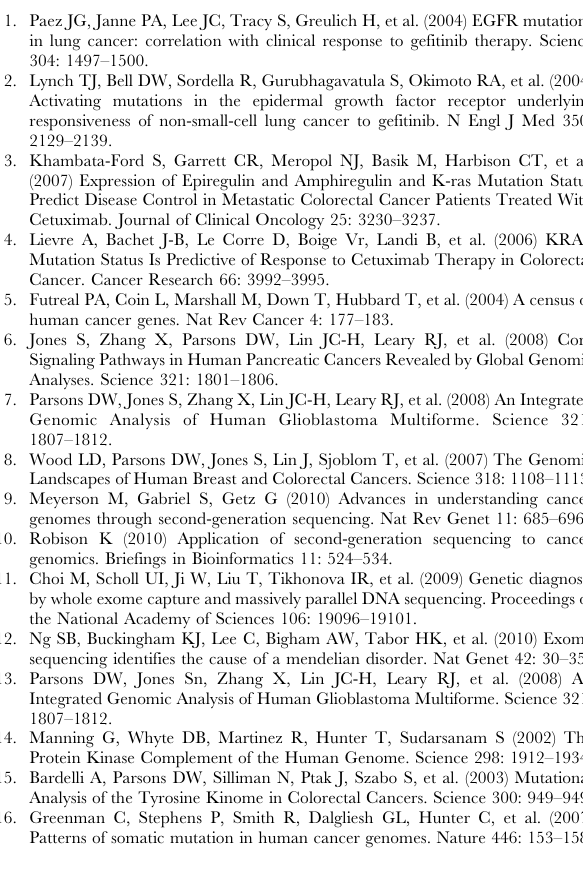
Table S3 440 protein kinase genes covered by the Nimblegen 2.1 M capture array.